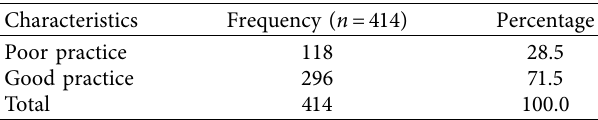
Table 3: Level of practice regarding mother’s health promotional measures of infant with age group 6–12 months in a tertiary hospital of